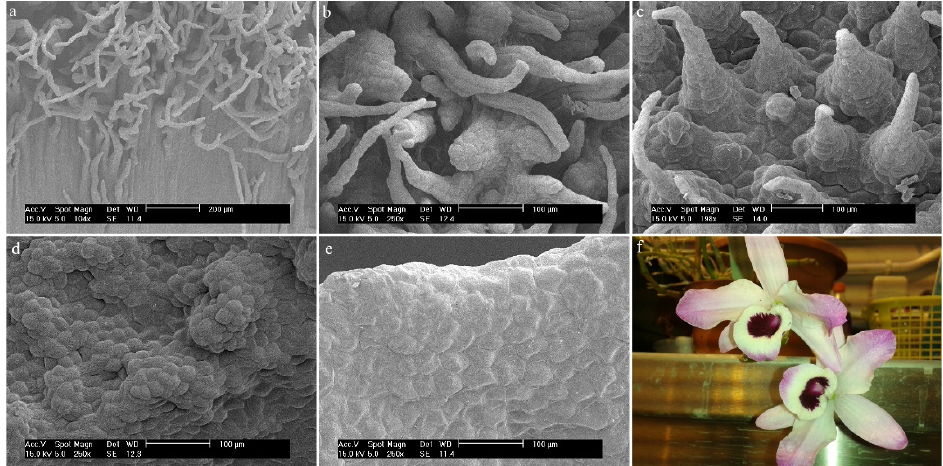
Figure 9. Dendrobium nobile Lindl: ( a , b ) trichomes of the hypochile part of the labellum; ( c ) trichomes of the mesochile part of the labellum; ( d ) margin of the mesochile part of the labellum; ( e ) margin of the epichile part of the labellum; ( f ) flower (photo by Monika Lipi ń ska).